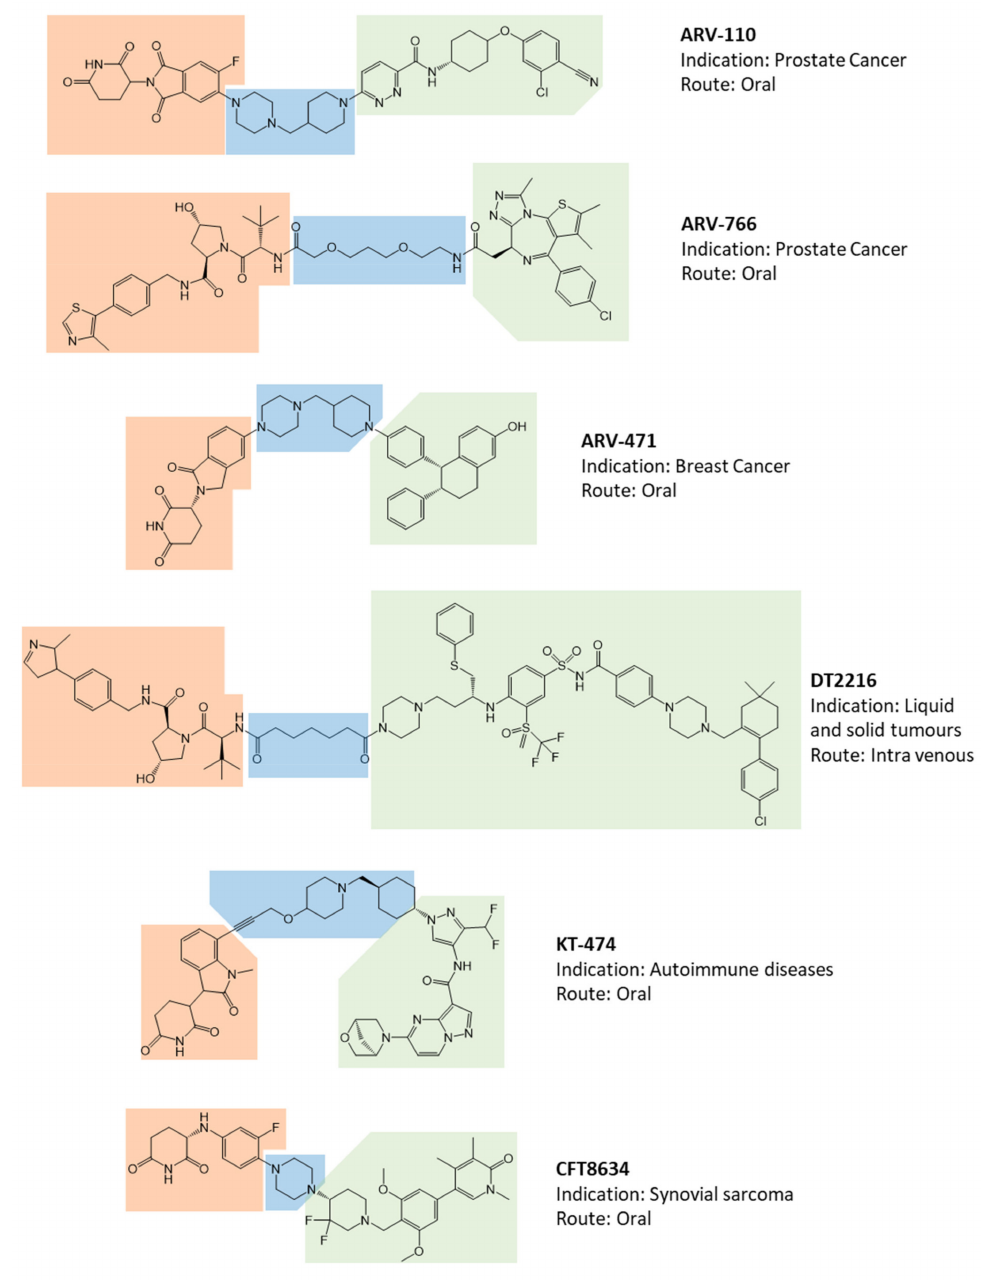
Figure 2. Available chemical structures, identification codes, indication, and route of administration of Proteolysis Targeting Chimeric molecules (PROTACs) involved in clinical trials. The molecular portions underlined in orange, green, and blue represent the E3 ligase-binding moiety, the protein of interest-binding moiety, and the linker,